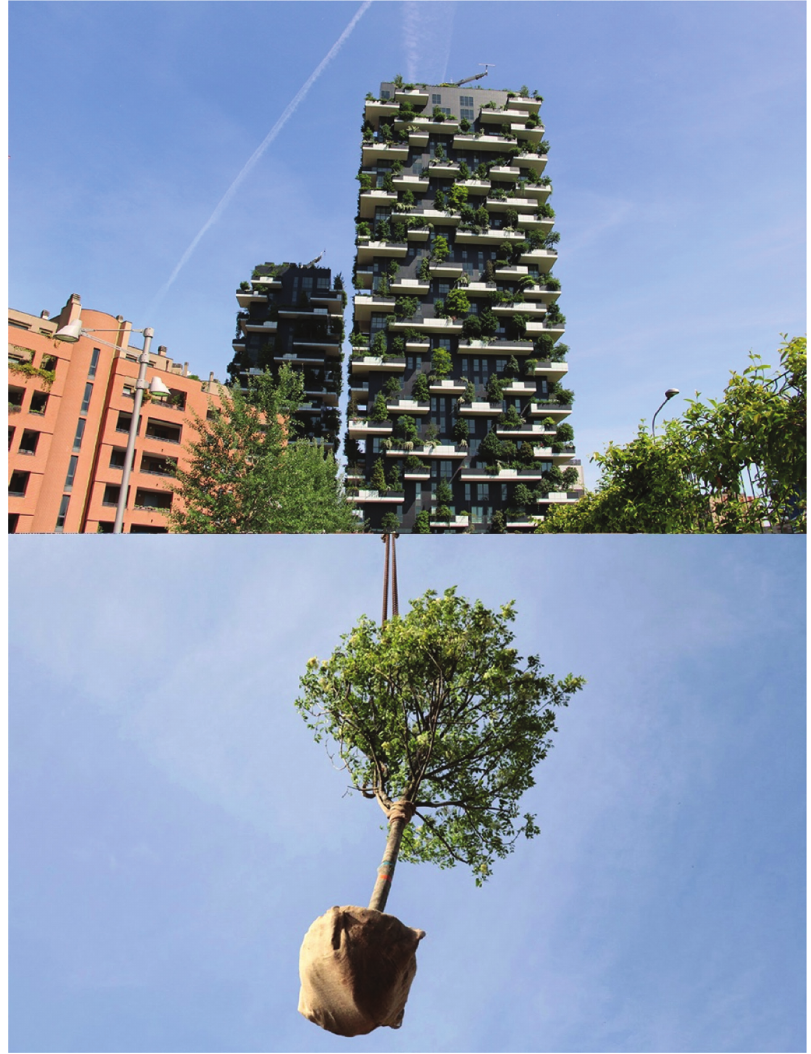
Figure 3. (a) Boeri’s Vertical Forest: Re-naturalized nature © Mauro Gambini. Image use granted under creative commons - Attribution 2.0 Generic (CC BY